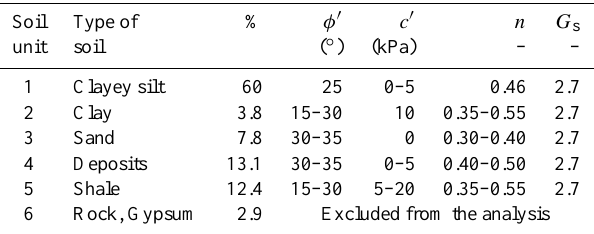
Table 1. Geotechnical parameters of the soil units in the study